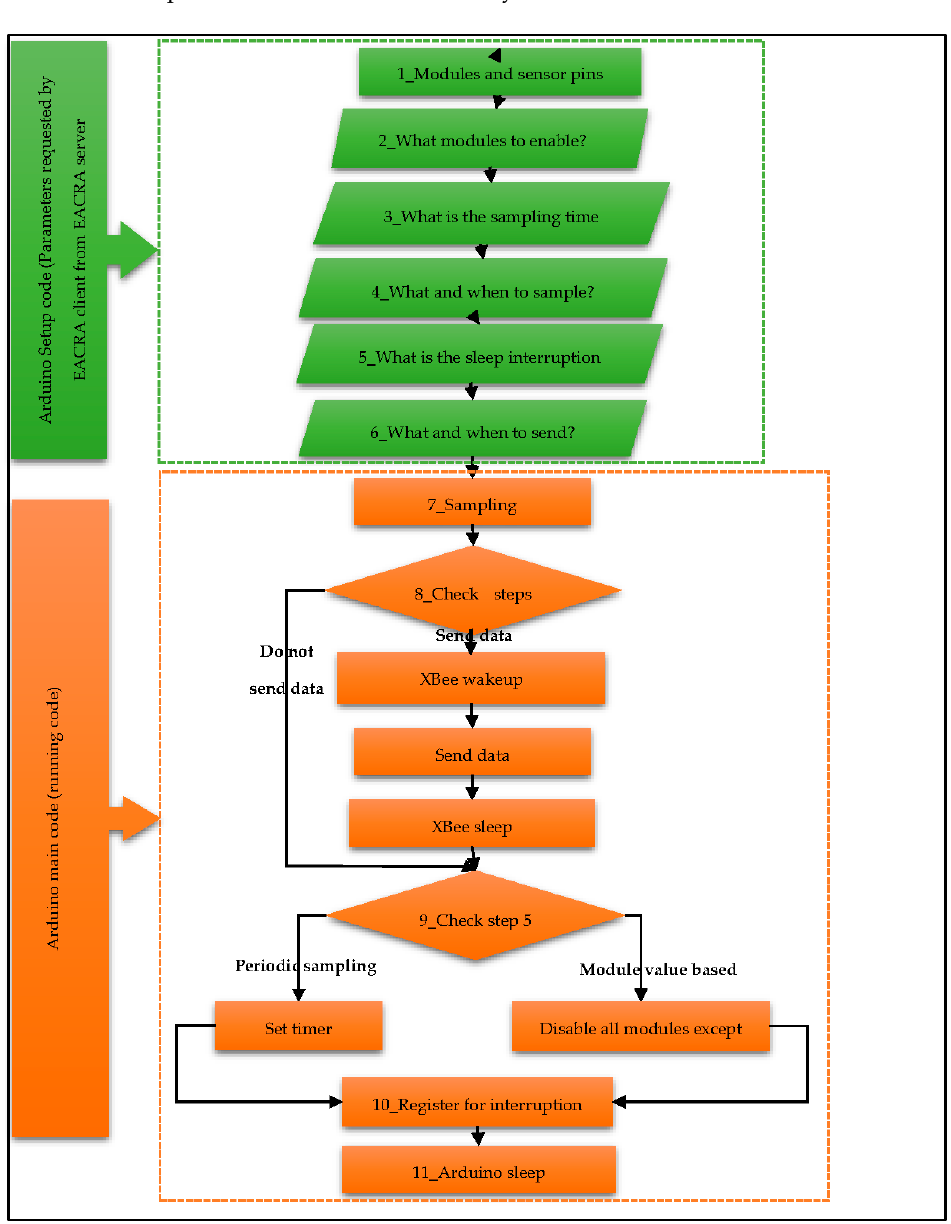
Figure 13. Energy Aware Context Recognition Algorithm (EACRA) Client algorithm.